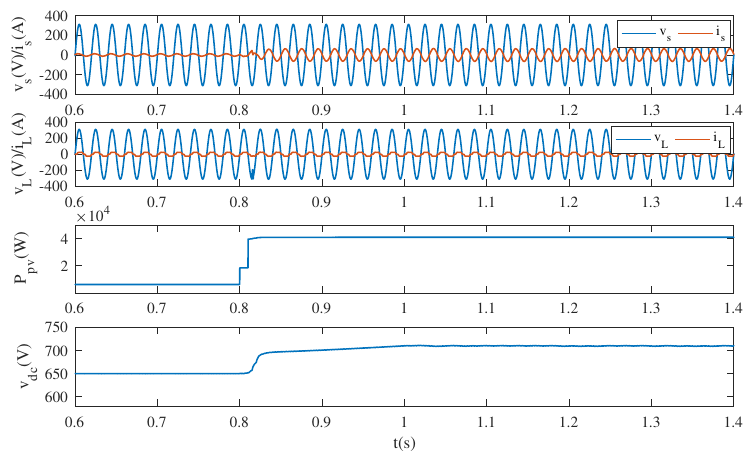
Figure 12. Simulation results under irradiation sudden